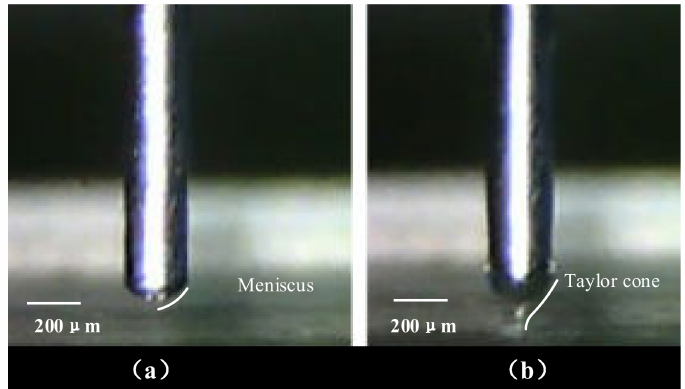
Figure 4. Photos of the droplet formation process on the nozzle: ( a ) a meniscus shape formed in the nozzle tip and ( b ) the Taylor cone formed under the action of the electric field force.